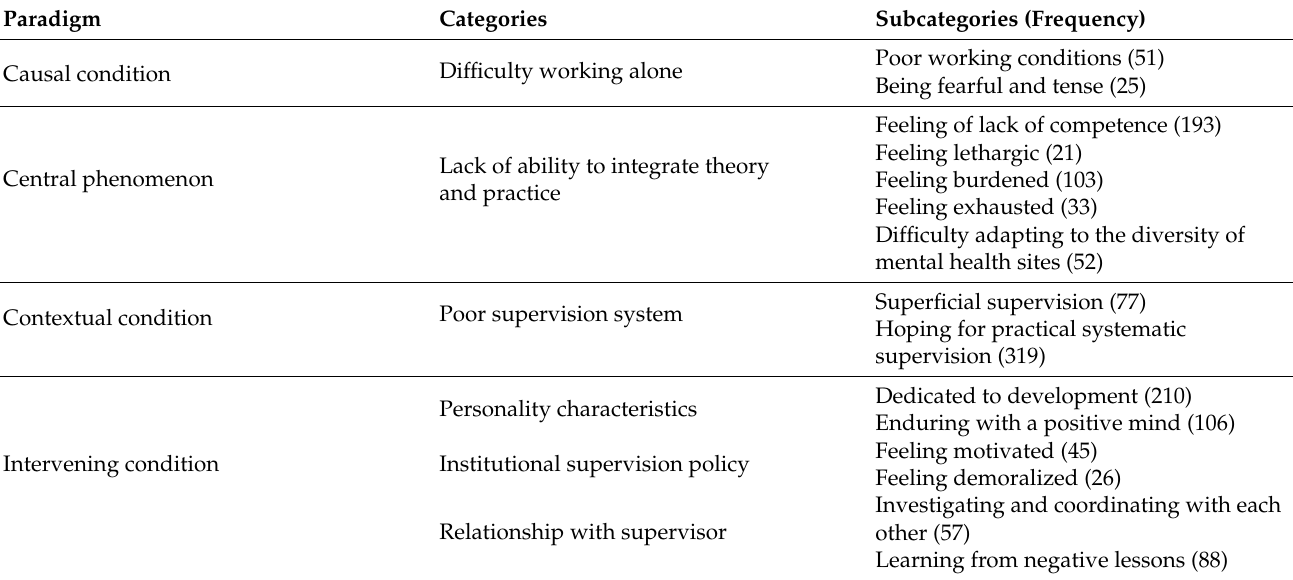
Table 2. Paradigm, categories, and subcategories of experiences in clinical supervision of psychiatric mental health nurse